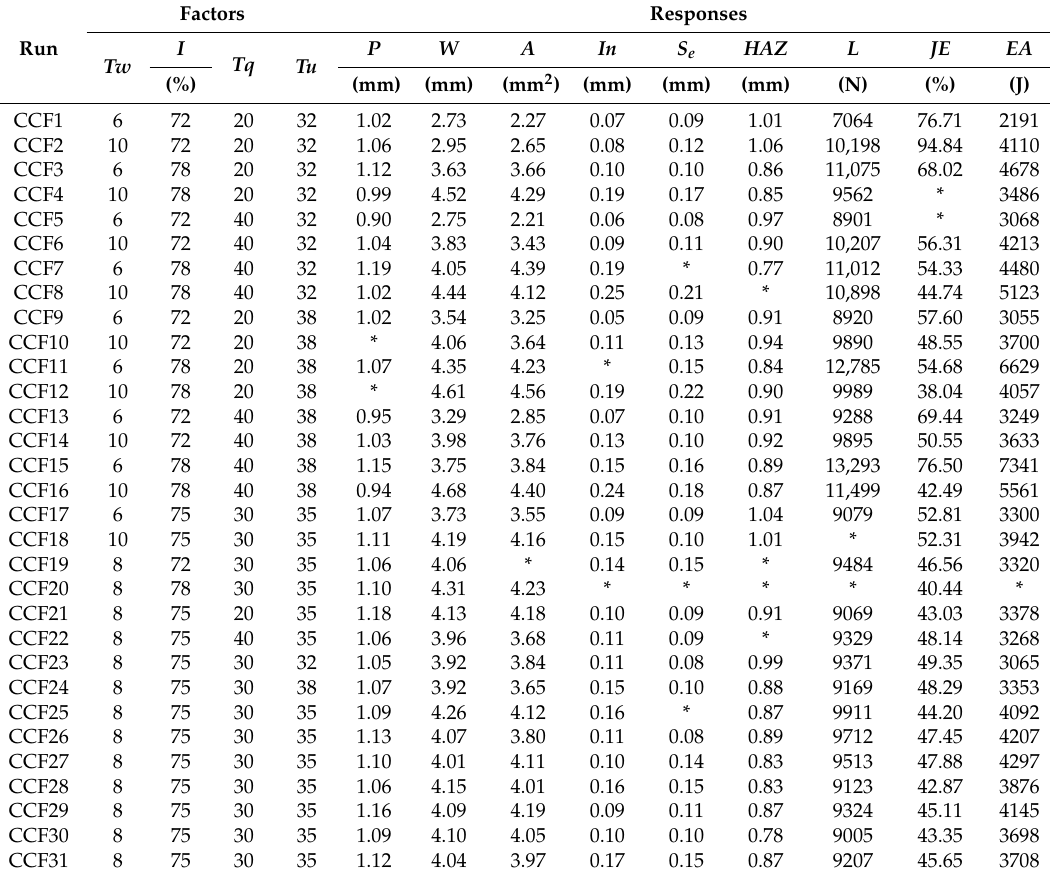
*—indicate the values that were removed after performing the residual analysis of the fitted